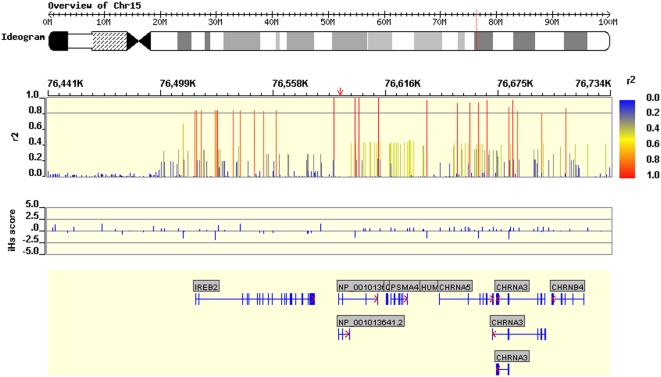
Region of Association around CHRNA3/CHRNA5.Annotated sections: Top: Linkage disequilibrium (r2) for all HapMap SNPs with rs8034191, showing an LD extension covering CHRNA3/CHRNA5. [red] r2≥0.8, [yellow] 0.5≤r2<0.8, [gray] 0.3≤r2<0.5, [blue] 0.2≤r2<0.3. Middle: Recent selection score. Bottom: genic context. Exons are depicted as blue vertical lines/rectangles, while introns are depicted as blue horizontal lines. Annotations were done using the WGAViewer software [31].